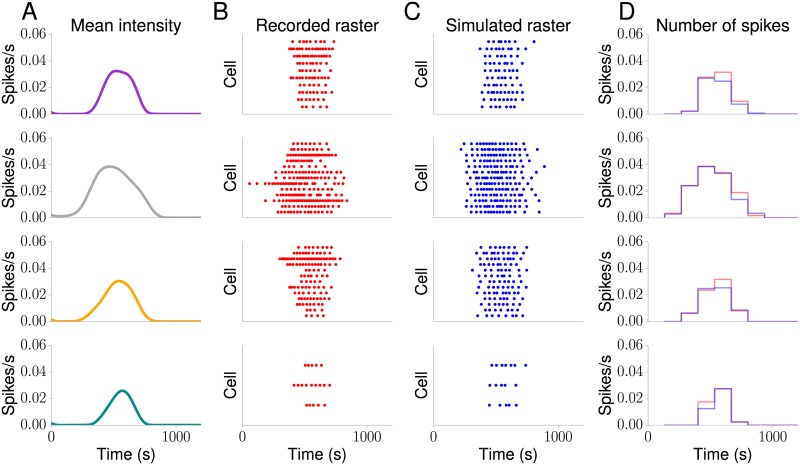
Surrogate Ca2+ spike sequences from experimentally determined Ca2+ spike rates.(A) Mean intensity functions as shown in Fig 7E. The colours correspond to the ones used in Fig 7. (B) Raster plot of recorded Ca2+ spike sequences as shown in Fig 7D. (C) Surrogate Ca2+ spike sequences generated from the mean intensity function depicted in (A). (D) Histograms of recorded and simulated Ca2+ spike sequences.